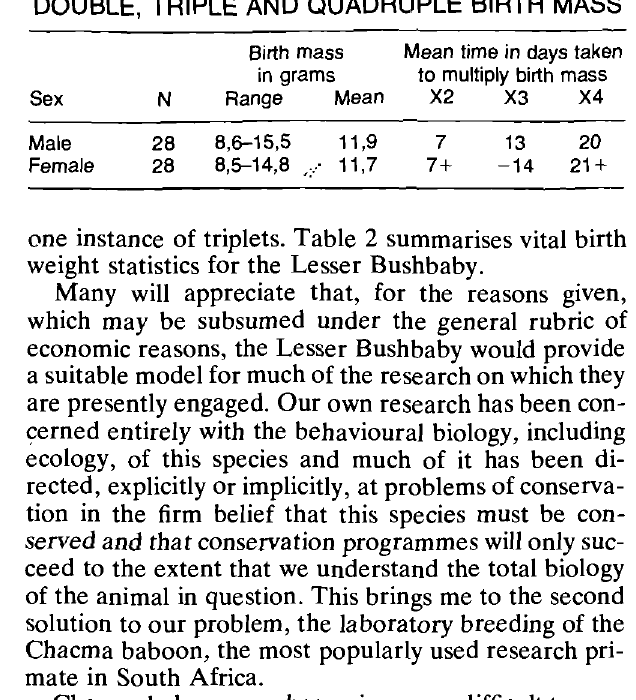
Table 2: VITAL BIRTH MASS STATISTICS FOR BOTH SEXES AND MEAN TIME TAKEN TO DOUBLE, TRIPLE AND QUADRUPLE BIRTH MASS Birth mass Mean time in days taken in grams to multiply birth mass